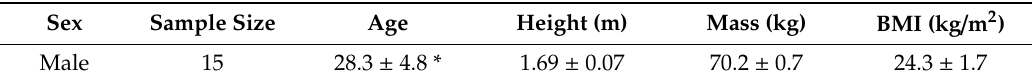
Table 1. Anthropometric data of subjects.